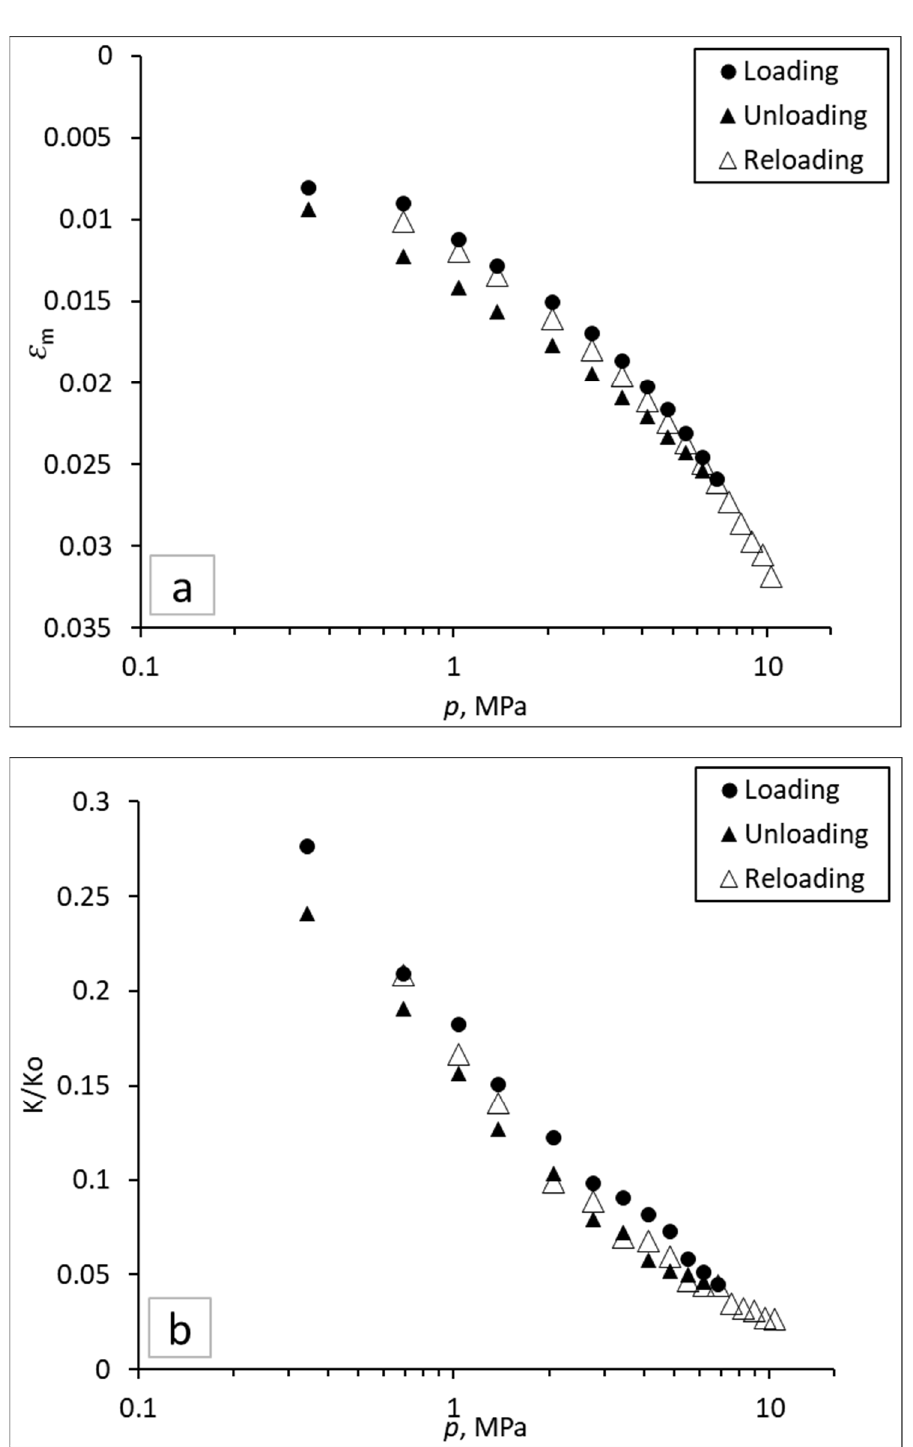
Figure 12. Strain and permeability hysteresis during stress loading–unloading–reloading (up to 10.3 MPa in test 4).